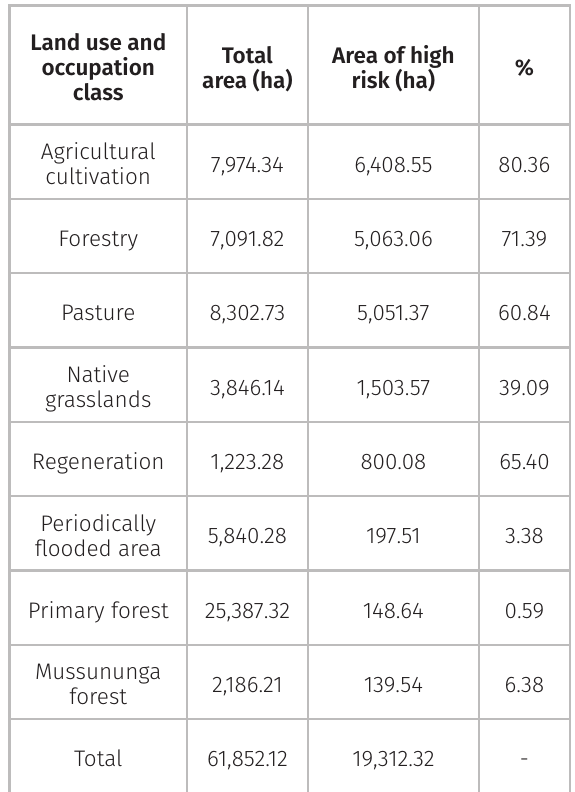
Table II. Main areas of high risk for the land use and occupation classes in the study area.